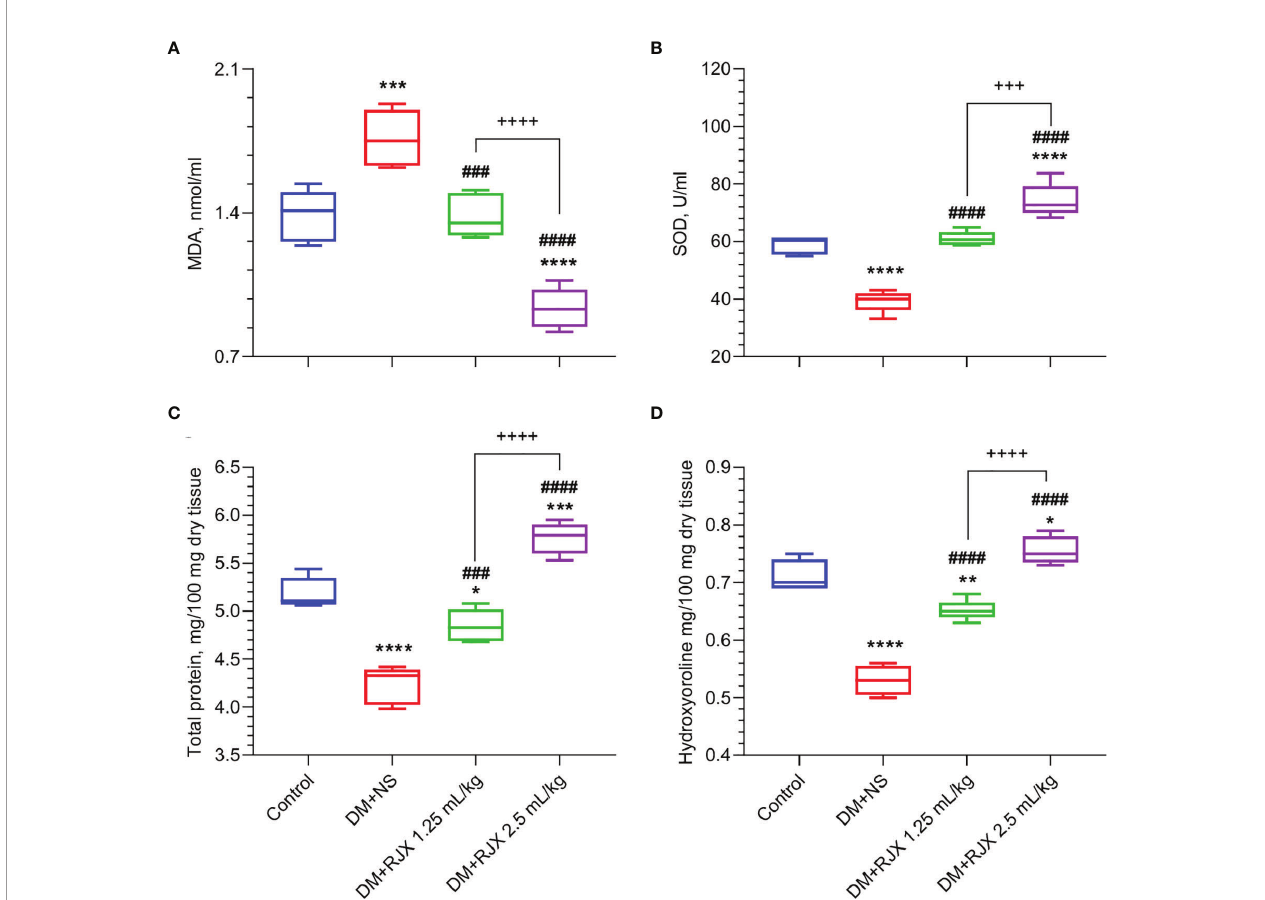
FIGURE 5 | The Effects of Rejuveinix (RJX) on Malondialdehyde (MDA, A ), Superoxide Dismutase (SOD, B ), Skin Total Protein (C) , and Hydroxyproline (D) in Diabetic Wound Healing. Groups of 20 Wistar albino rats were treated with i.p injections of RJX (1.25 mL/kg and/or 2.5 mL/kg), or vehicle (NS). Except for untreated control rats (Control), each rat was fed a high-fat diet (HFD) for 4 weeks and injected a single dose of streptozotocin (STZ, 45 mg/kg i.p.) to induce diabetes (DM). At the end of 4 weeks, an experimental wound with a diameter of 5 mm was formed in all rats. On day 21, fi ve rats (n=5) in each group were selected. The depicted Whisker plots represent the median and min- max values. ANOVA and Tukey ’ s post-hoc test were used for comparing the results among different treatment groups. Statistical signi fi cance between groups is shown by *p<0.05; **p<0.01; ***p<0.001; ****p<0.0001 as compared to control group, and ### p<0.001; #### p<0.0001 as compared to DM+NS group, and +++ p <0.001; ++++ p <0.0001 pairwise comparisons between the